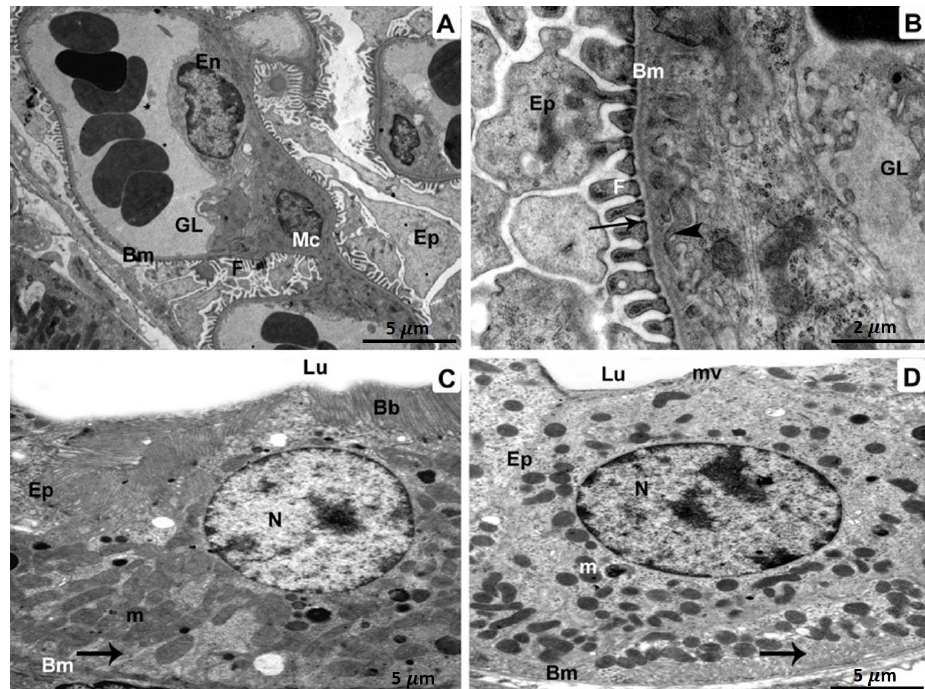
Figure 4. Specimens of BPA- and ATX-treated group, as seen in TEM: A glomerulus containing glomerular capillaries (GL), a basement membrane (Bm), endothelium (En), a mesangial cell (MC), and podocytes (Ep) with foot processes. ( A ). 5 µm scale bar; ( B ) A greater magnification showing a glomerular capillary (GL) bordered by a basement membrane (Bm) 2 µm scale bar. A three-layered glomerular membrane with fenestrations (arrowheads), foot processes (F), as well as podocytes (Ep) is shown. Epithelial cells (Ep) are seen in a cross-section of a proximal tubule ( C ) resting on the basement membrane (Bm). The nucleus (N), in addition to infolding membranes (arrow), are both present, as are the mitochondria (M) (m). 5 µm scale bar; Epithelial cells (Ep) resting on the basement membrane, as seen in a cross-section of a distal tubule ( D ) (Bm). We can observe the undamaged, intact nucleus (N), infolding membranes (arrow), as well as functioning intact mitochondria (m). 5 µ m scale